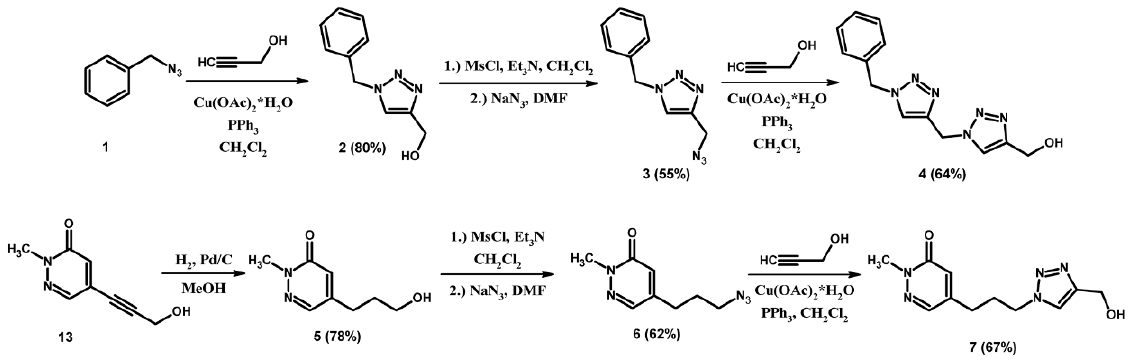
Scheme 1. Synthesis of mono- ( 2 ), bis-triazole ( 4 ) and pyridazinone ( 7 ) derivatives.